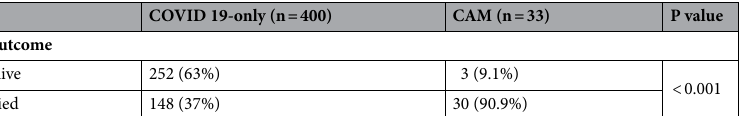
COVID 19-only (n =